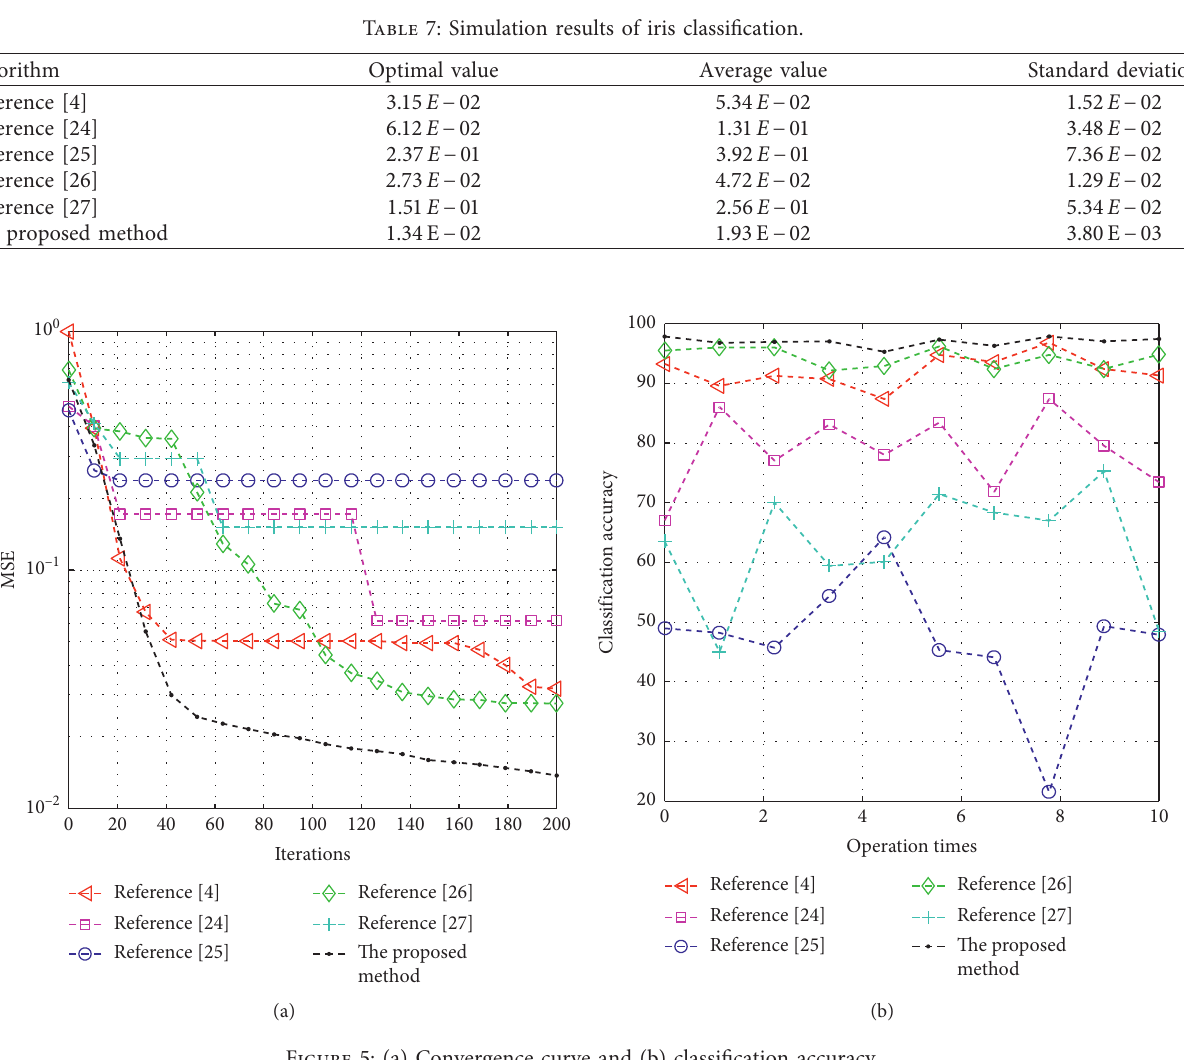
Figure 5: (a) Convergence curve and (b) classification